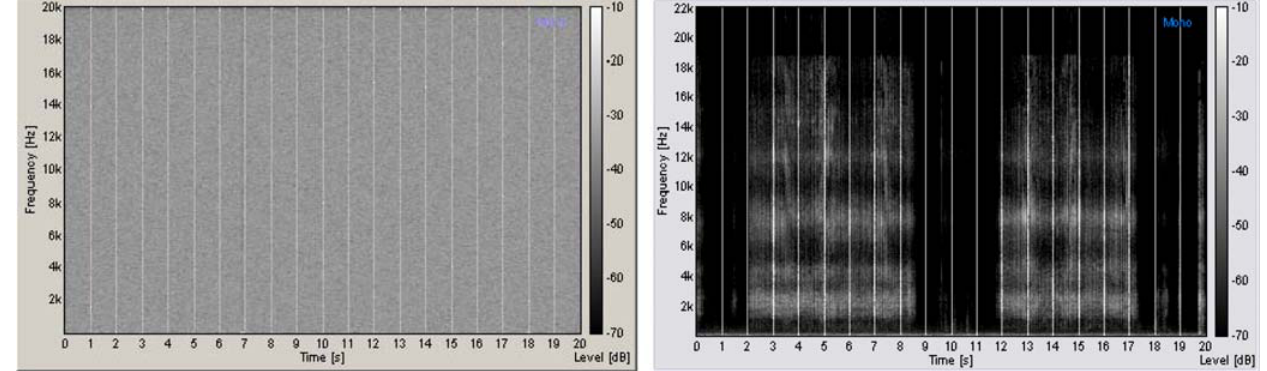
Figure 10. Auditory stimuli representation. Frequency-time representation of auditory noise (left) and the 3D sound (right).